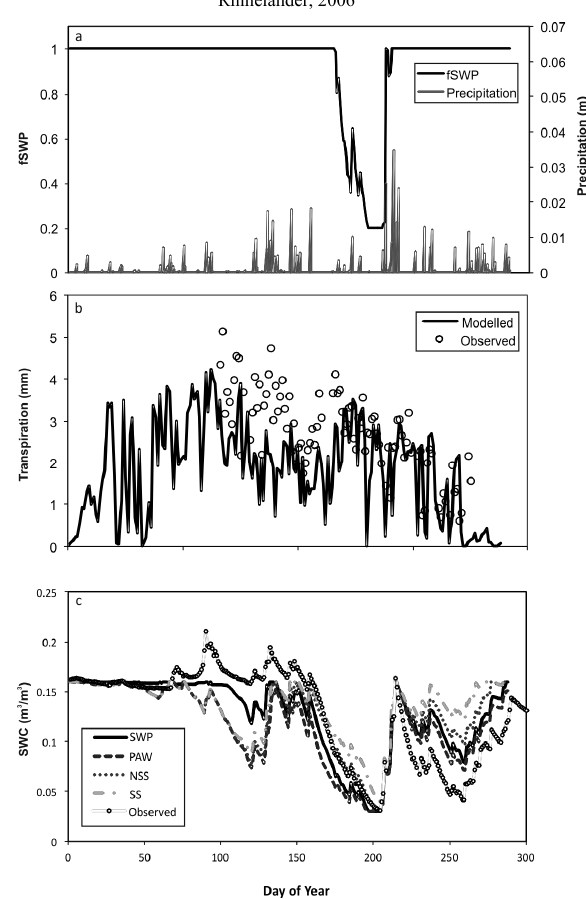
f04 Fig. 4. (a) Modelled f SWP and measured precipitation for a mixed aspen-birch stand at Rhinelander in 2006 using the SWP model; (b) Observed and modelled transpiration for the same year, stand and soil water calculation method; (c) Observed and modelled soil water content (SWC) using all four methods that relate soil water to g sto (see methods section for